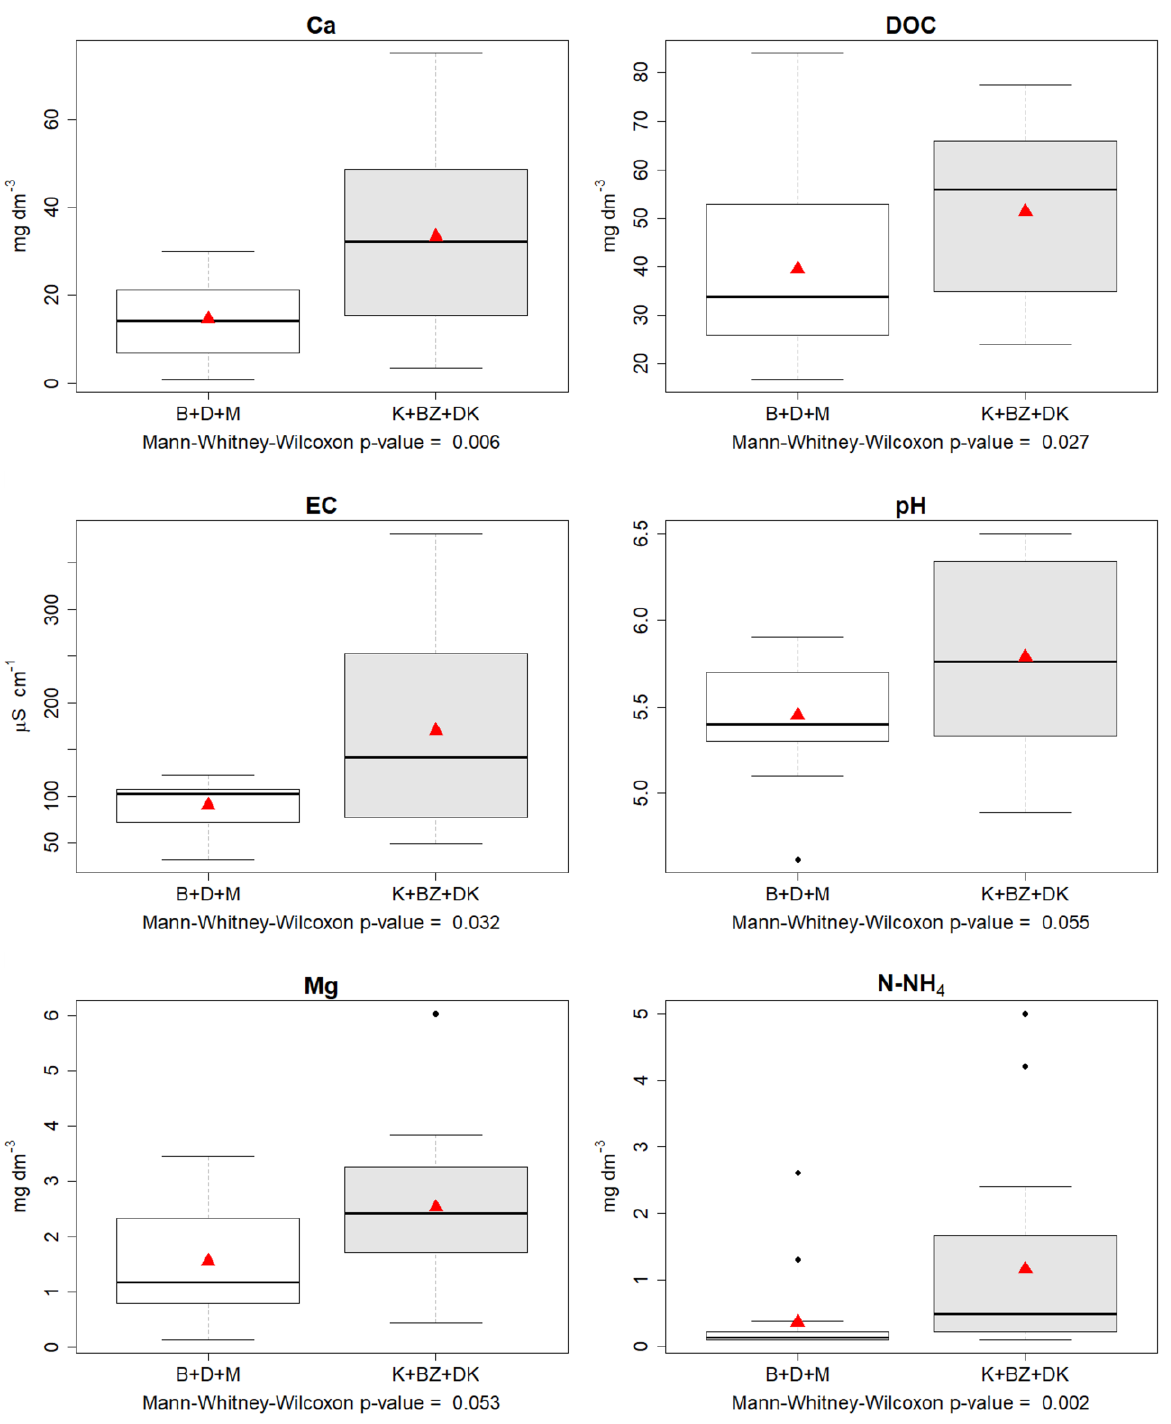
Figure 3. Distribution of values of the investigated physicochemical properties of piezometric groundwater which may have a limiting effect on Comarum palustre in 2011–2013, at the study sites Lake Bikcze (B), Lake Karaśne (K), Lake Długie (D), Lake Moszne (M), the mid-forest bog Blizionki (BZ) and the Dekowina (DK) wetland sanctuary. Mann-Whitney-Wilcoxon p-values indicate significance level of differences between site groups. In each boxplot, the box represents the first and third quartiles and the horizontal line dividing the box represents the median. The mean is indicated by the filled red triangle. The whiskers extend to the most extreme observations that are located no more than 1.5 times the interquartile range away from the box. Any observation not included between the whiskers is considered an outlier and is represented by a black dot along the whisker-axis. When there are no outliers, the whiskers terminate at the minimum and maximum